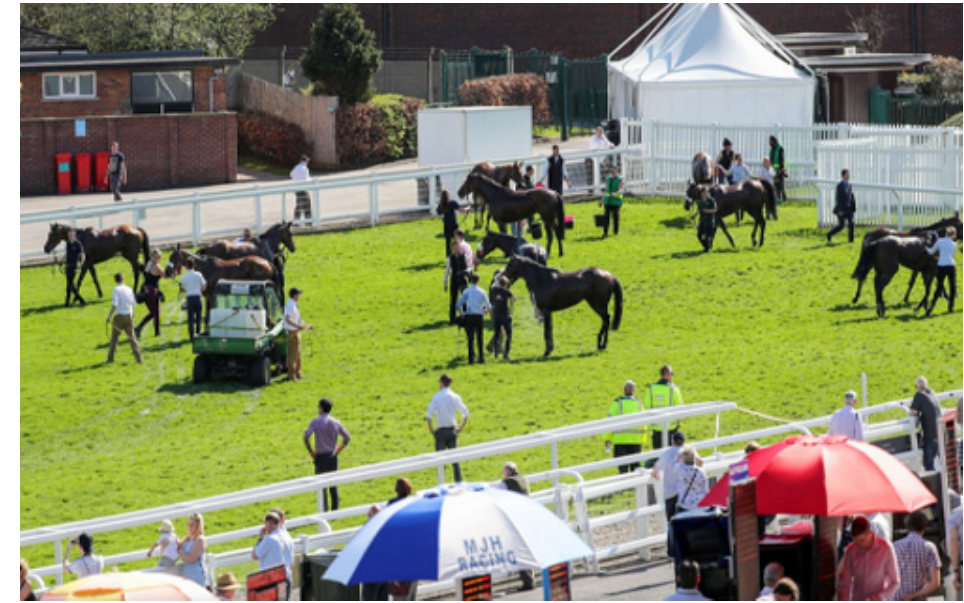
Figure 23. A mobile cold water spray unit in use after a race in the UK.